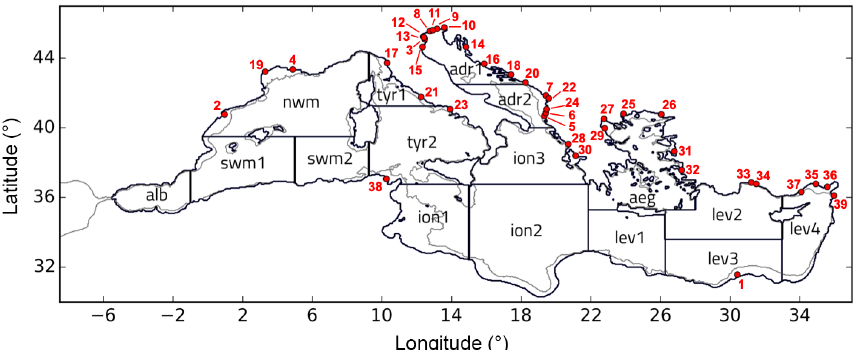
Figure 2. Subdivision of the model domain in sub-basins used for the validation of the qualification run. According to data availability and to ensure consistency and robustness of the metrics, different subsets of the sub-basins or some combinations among them can be used for the different metrics: lev = lev1 + lev2 + lev3 + lev4; ion = ion1 + ion2 + ion3; tyr = tyr1 + tyr2; adr = adr1 + adr2; swm = swm1 + swm2. The grey line defines the bathymetric contour at 200m. Red dots with numbers correspond to river mouth positions: Nile (1), Ebro (2), Po (3), Rhone (4), Vjosë (5), Seman (6), Buna/Bojana (7), Piave (8), Tagliamento (9), Soca/Isonzo (10), Livenza (11), Brenta-Bacchiglione (12), Adige (13), Lika (14), Reno (15), Krka (16), Arno (17), Nerveta (18), Aude (19), Trebisjnica (20), Tevere (21), Mati (22), Volturno (23), Shkumbini (24), Struma/Strymonas (25), Meric/Evros/Maritsa (26), Axios/Vadar (27), Arachtos (28), Pinios (29), Acheloos (30), Gediz (31), Buyuk Menderes (32), Kopru (33), Manavgat (34), Seyhan (35), Ceyhan (36), Gosku (37), Medjerda (38), and Asi/Orontes